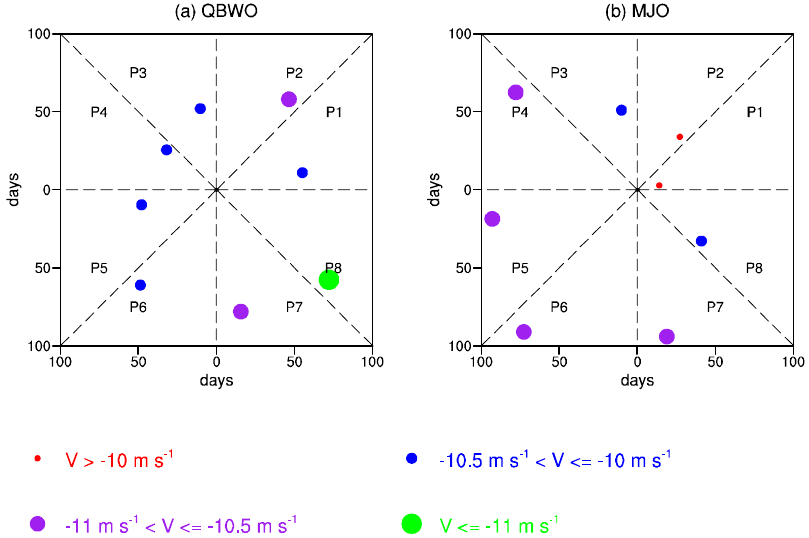
Figure 12. Two − dimension distribution of frequency (unit: days) and intensity (unit: ms − 1 ) of cold surges during different ( a ) QBWO phases and ( b ) MJO phases. Frequencies of cold surges during phases 1–8 and phases 4–5 (phases 2–3 and phases 6–7) of ISO modes should be referred to the values in x-axis (y-axis). Intensity of cold surges is defined as the 925 hPa meridional winds averaged over the South China Sea between 110 ◦ E and 117.5 ◦ E along 15 ◦ N. Different intensities are indicated with dots in different colors and sizes.